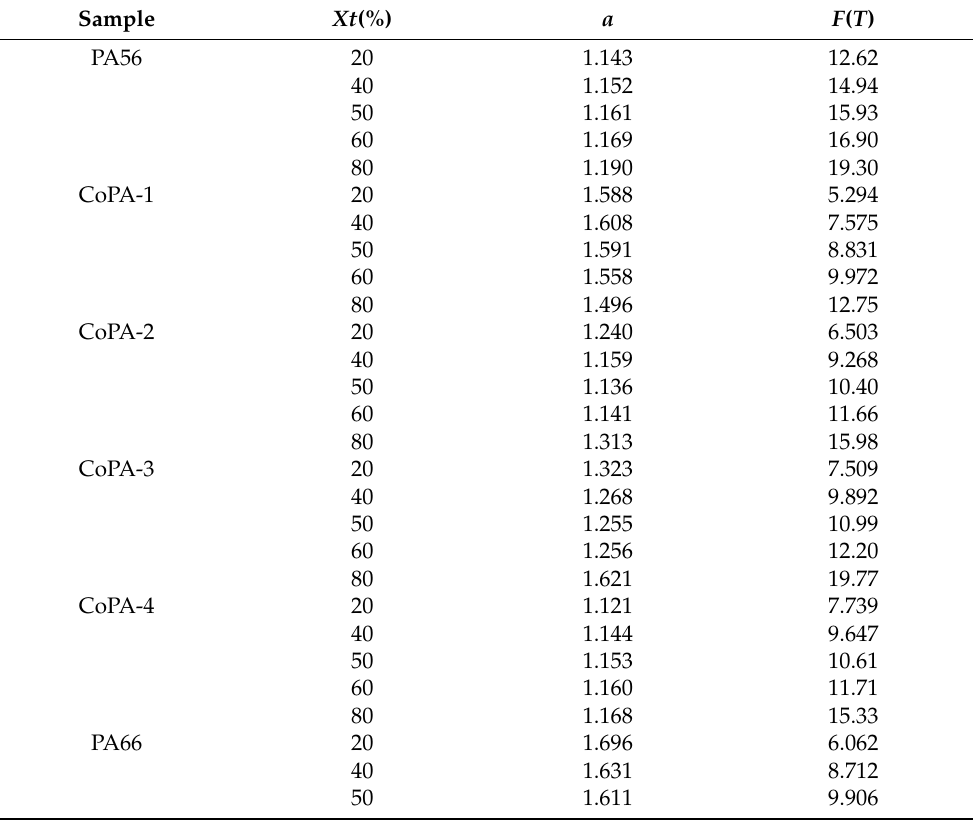
Figure 13. Plots of log Φ versus log t for nonisothermal crystallization of ( a ) PA56, ( b ) CoPA-1, ( c ) CoPA-2, ( d ) CoPA-3, ( e ) CoPA-4 and ( f ) PA66 at different values of relative crystallinity. Table 7. Nonisothermal crystallization kinetics by the Mo method.